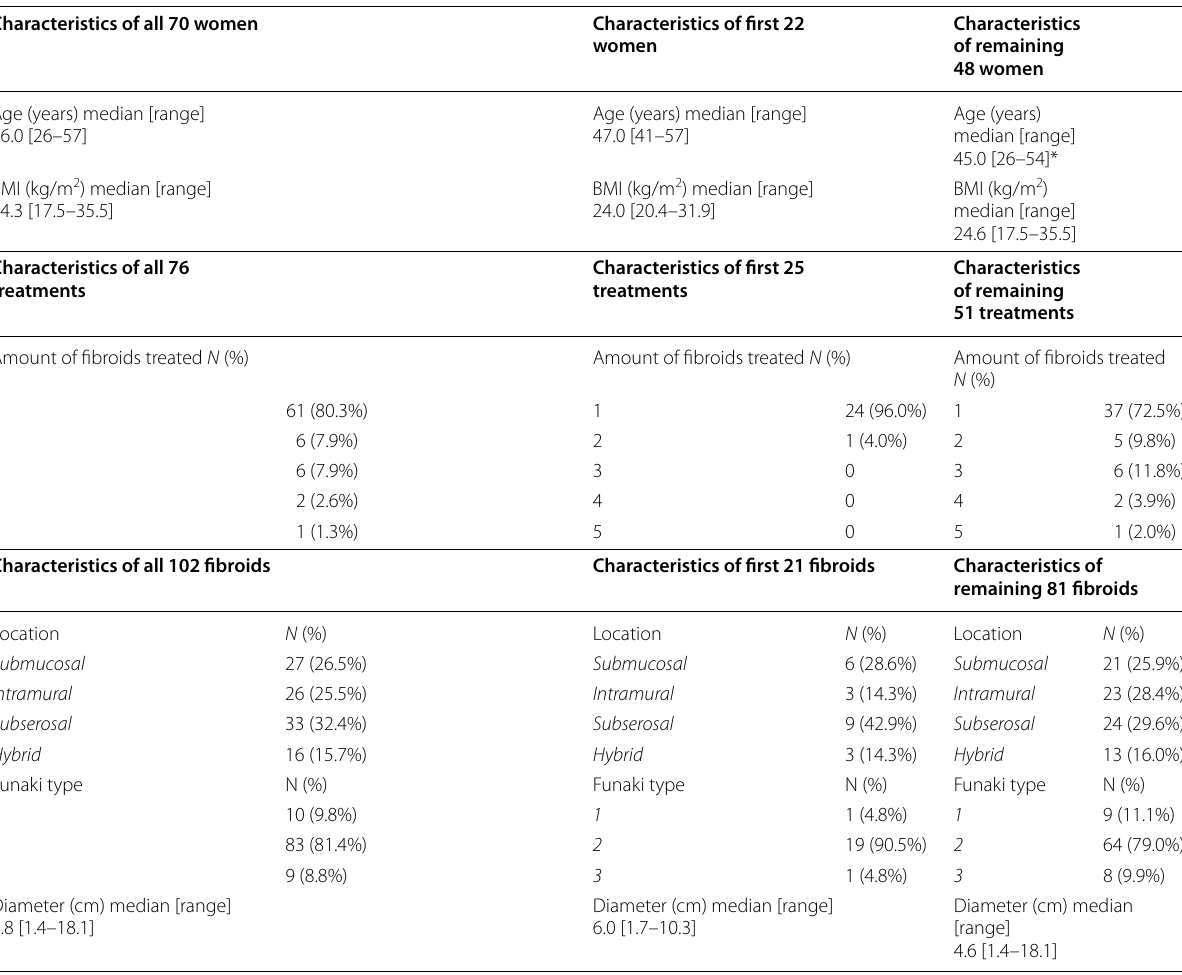
Table 2 Demographic and clinical characteristics of 70 women who underwent MR‑HIFU